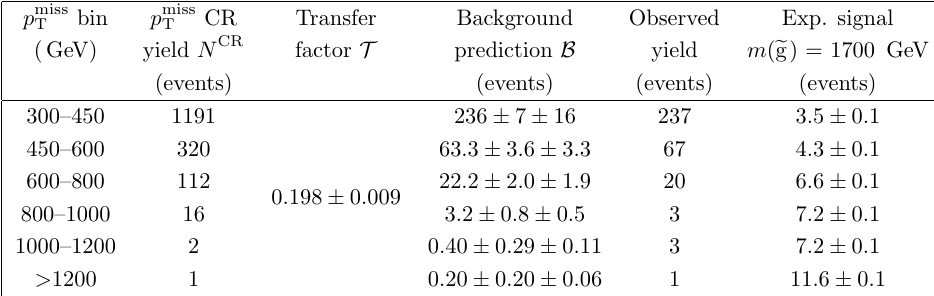
Table 2 . Number of events in the p miss CR, transfer factor, background prediction, and observed T yield in each of the six p miss T